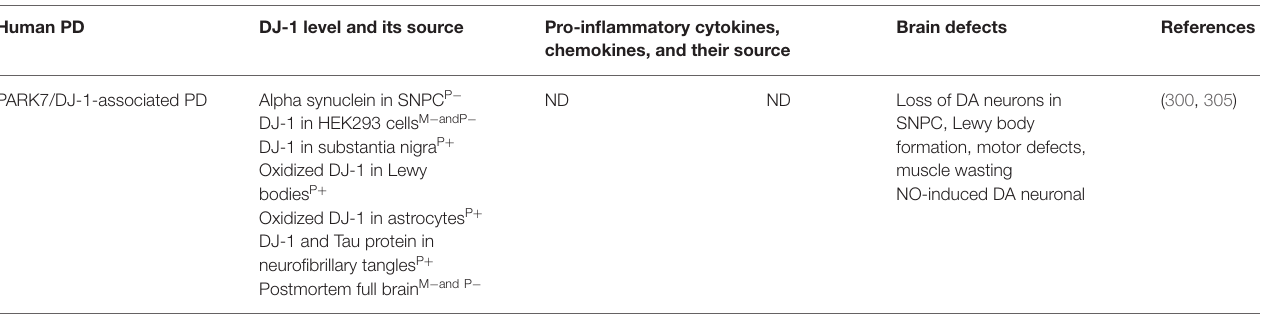
TABLE 7B | Cytokines and their source in the PARK7-associated human